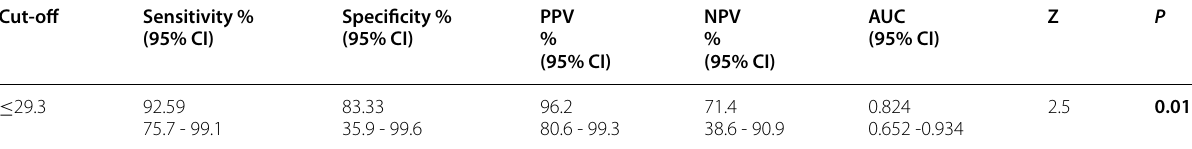
CI Confidence interval, PPV Positive predictive value, NPV Negative predictive value